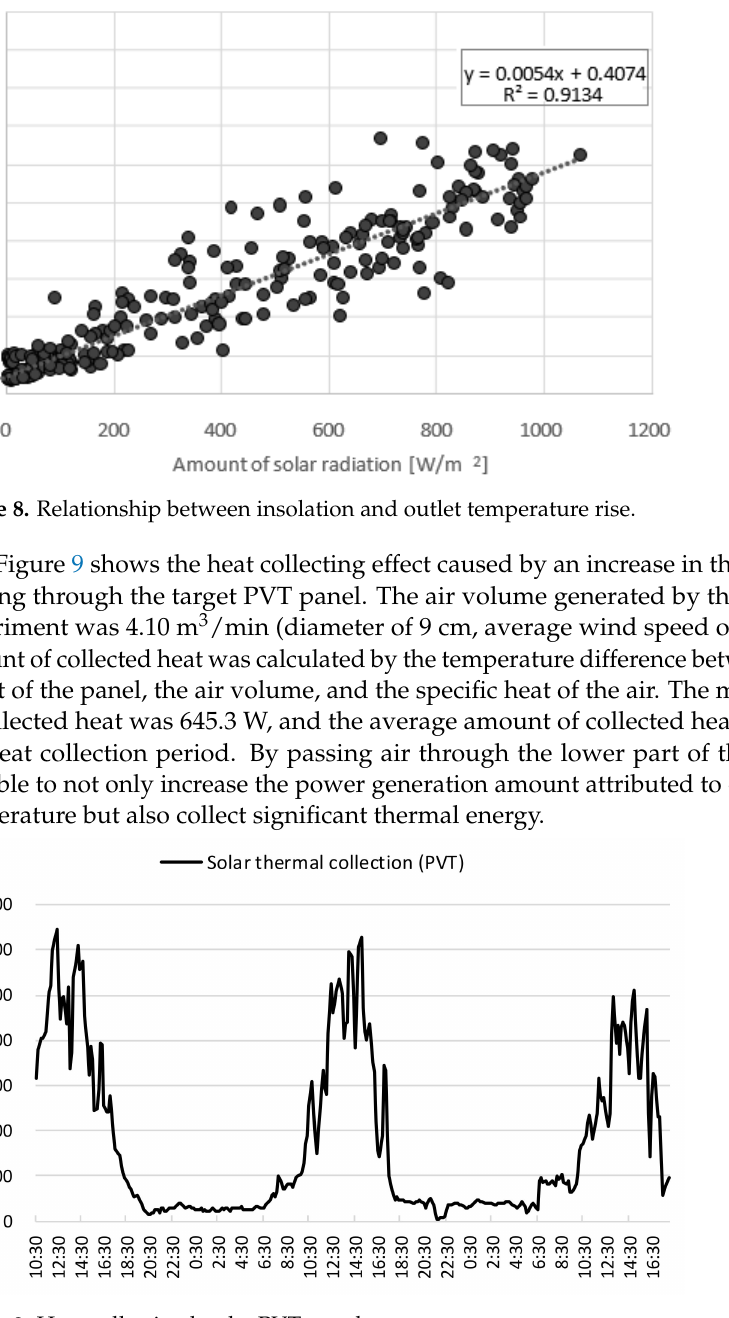
Figure 9. Heat collection by the PVT